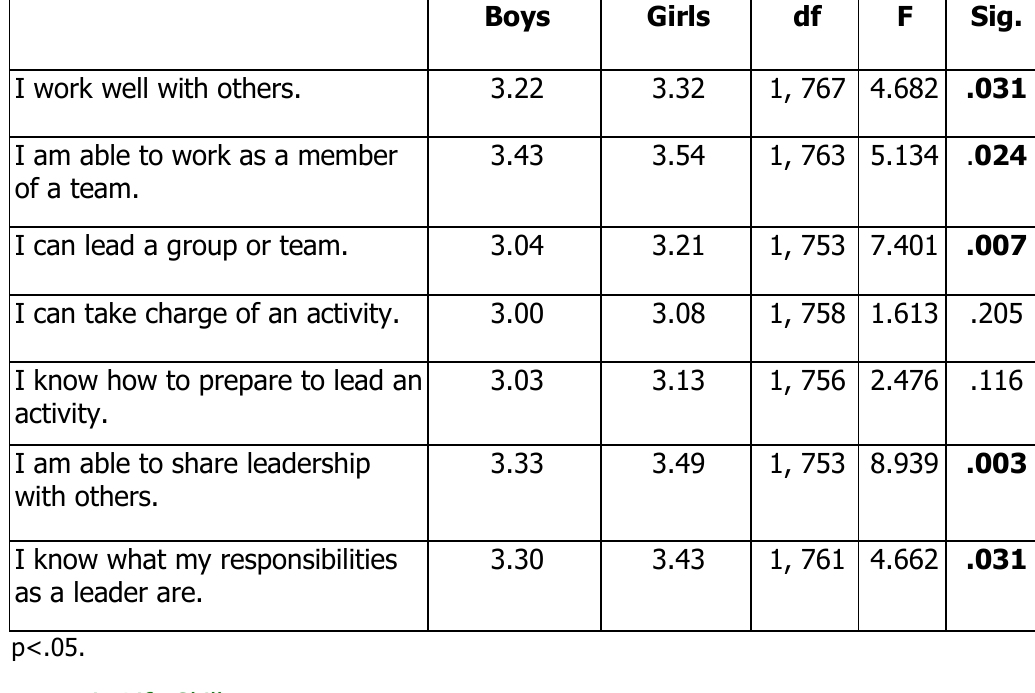
Boys Girls df F